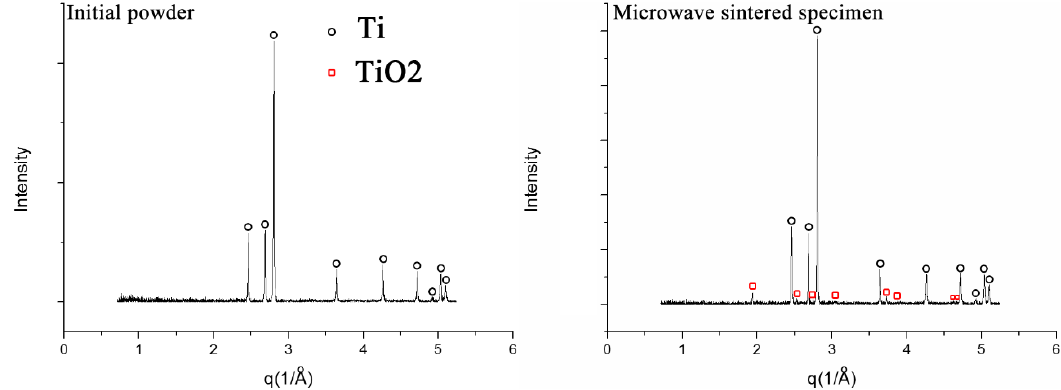
Figure 7. X-ray diffraction patterns of the powder and specimen.